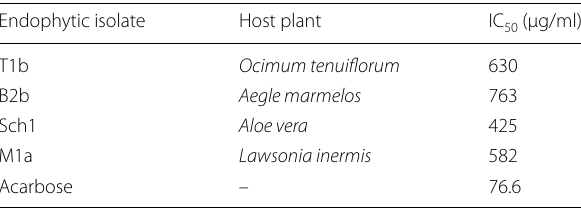
Table 1 IC values of endophytic isolates possessing high 50